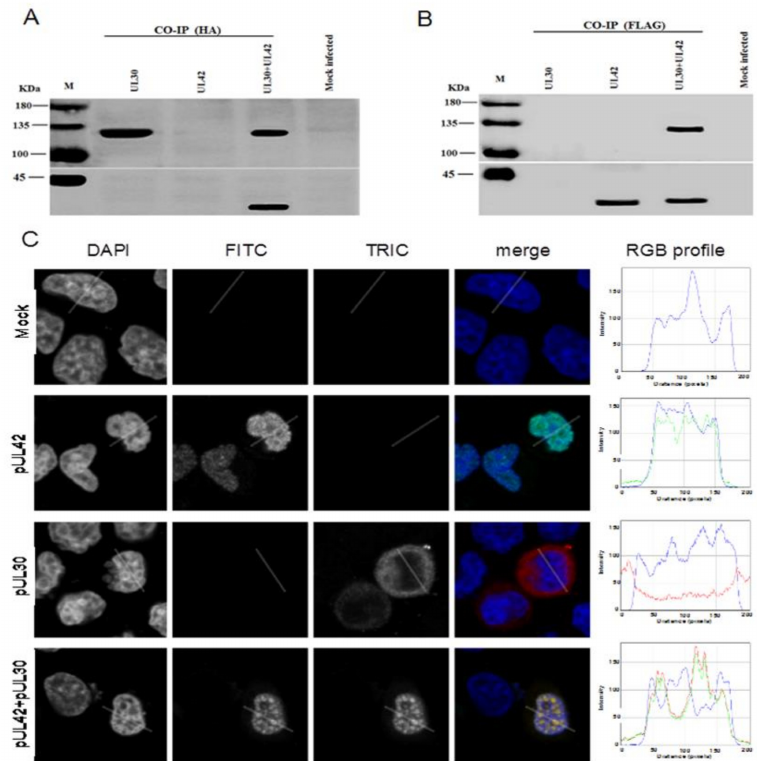
Figure 2. Expression of pUL42 is required for nuclear transport of pUL30 in the absence of other viral proteins. MDBK cells were transiently transfected to express the indicated fusion proteins and the cell lysates were subjected to Co-IPs by using anti-HA ( A ) and anti-FLAG ( B ) antibodies. Immunoprecipitated proteins were subjected to SDS-PAGE / Western blotting assays to detect the pUL30-HA and pUL42-FLAG fusion proteins using anti-HA (upper panels) or anti-FLAG (lower panels) monoclonal antibodies. The positions of the protein markers (M) are indicated on the left. Data shown are a representative one of three independent experiments. ( C ) MDBK cells were transiently transfected to express the indicated fusion proteins, processed for in situ immunofluorescence and subjected to CLSM analysis using anti-HA or anti-FLAG monoclonal antibodies. The cell nuclei (DAPI) along with the pUL42-FLAG (FITC) and the pUL30-HA (TRITC) fusion proteins are shown, in grayscale, along with respective RGB merged images of the three channels (merge). RGB profile plots relative to the indicated areas were shown on the right panels (RGB profile). Images are representative of three independent transfection